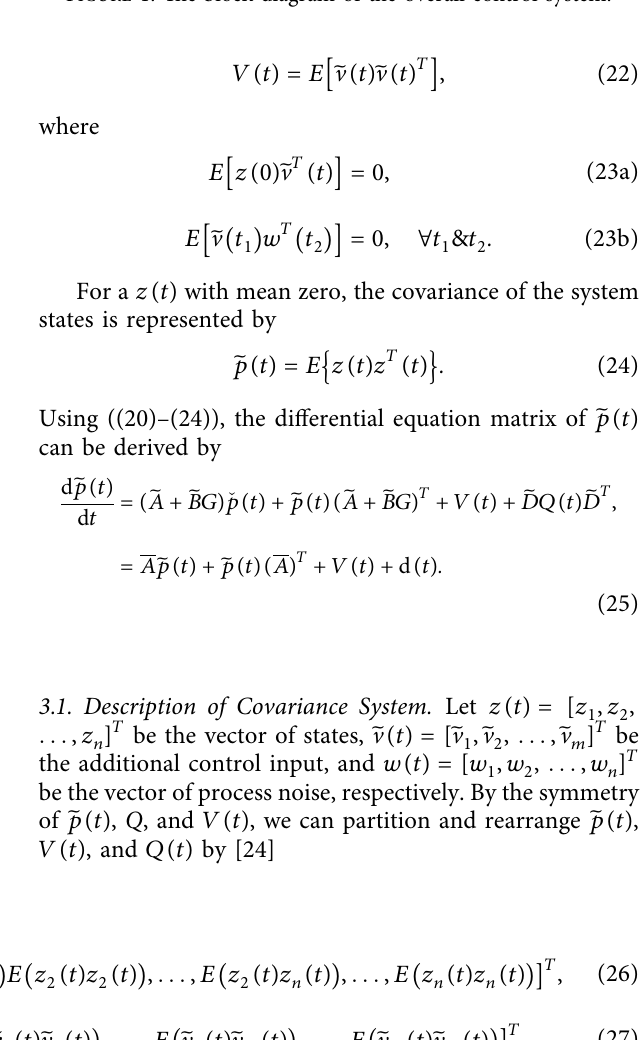
Figure 1: The block diagram of the overall control